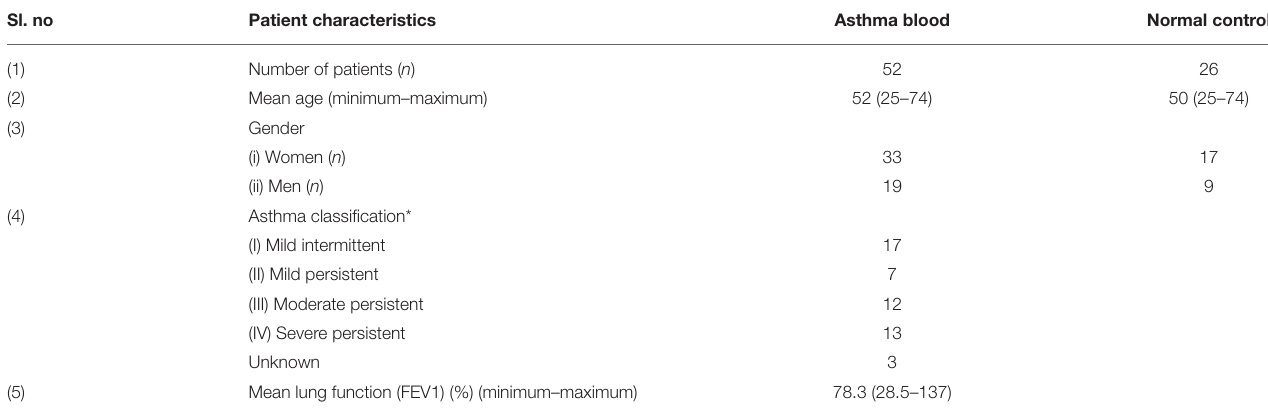
TABLE 2 | Basic characteristics of asthmatics and